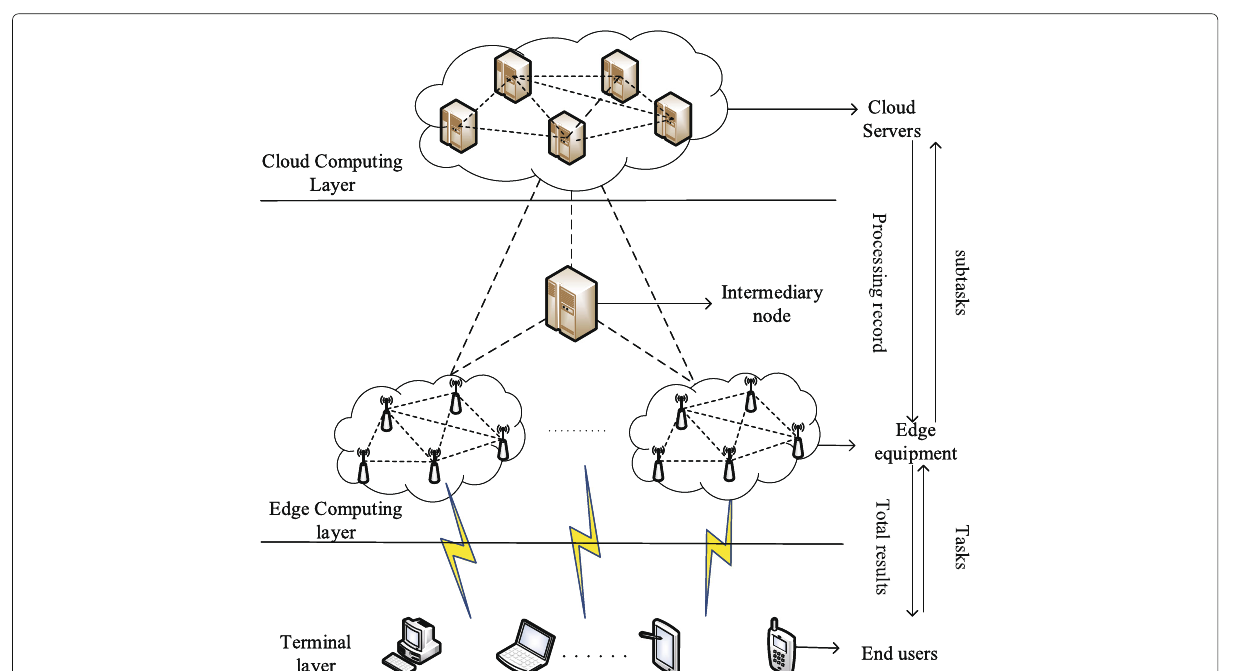
Fig. 1 Network architecture of edge computing based on mediation